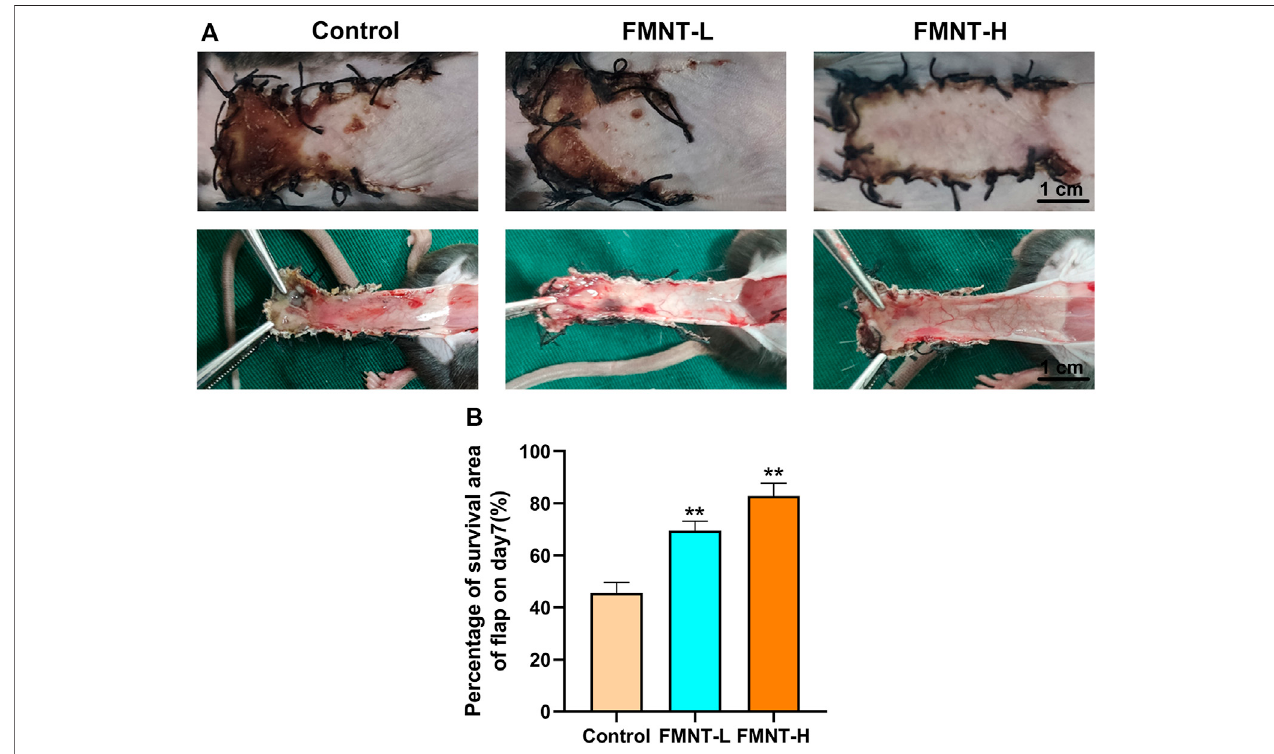
FIGURE1|(A) Macroscopicviewofarandomskin fl aponthebackofaratonday7aftersurgery(externalandafter fl aplift)(scalebar:1 cm) (B) Survivalratesofthe three groups of fl aps. All data represent mean ± SD. ** p ≤ 0.01 compared to the control